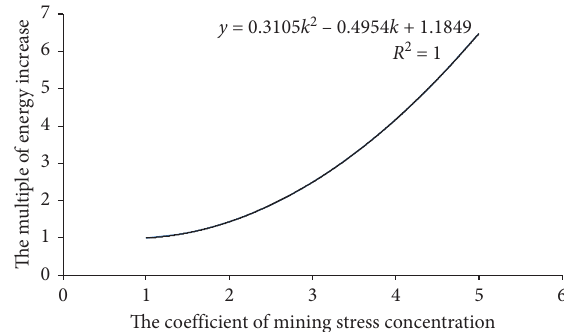
Figure 3: Relationship between the multiple of energy increase and the coefficient of mining stress concentration in the Wudong coal